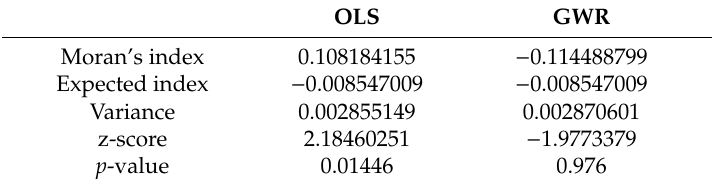
Figure 5. Local indicator of spatial association (LISA) cluster maps of residuals in the OLS and GWR models. Colors indicate significant positive (red and pink), negative (pale blue and yellow), and not significant (blue) spatial autocorrelation. (a) LISA cluster map of residuals of OLS model for the average ridership across the whole week. (b) LISA cluster map of residuals of GWR model for the average ridership across the whole week.